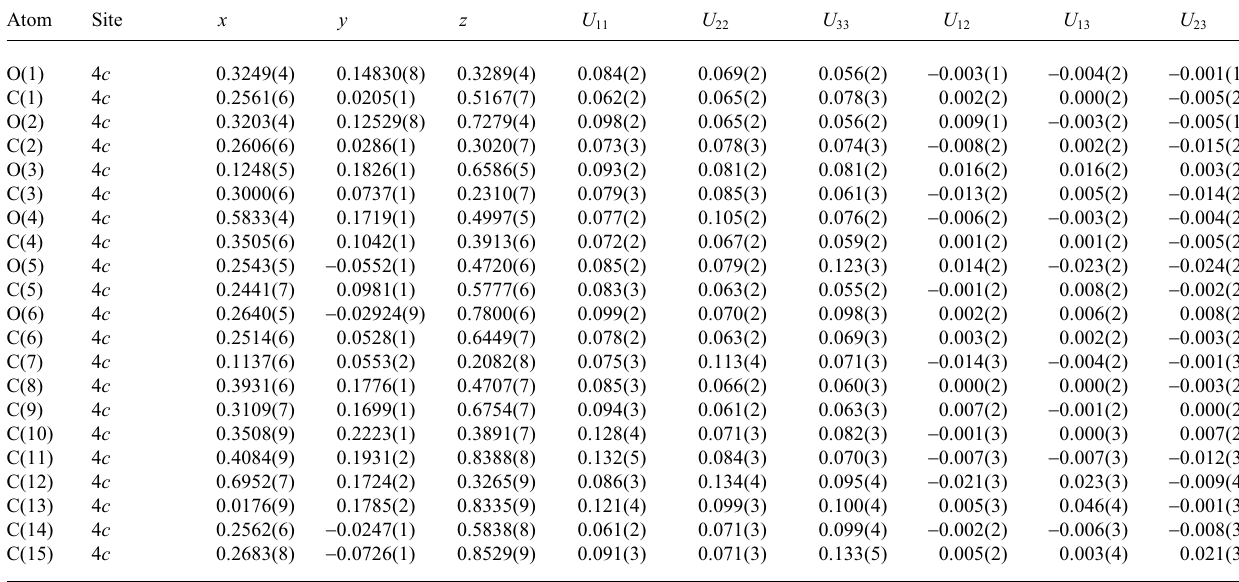
Table 3. Atomic coordinates and displacement parameters (in Å 2